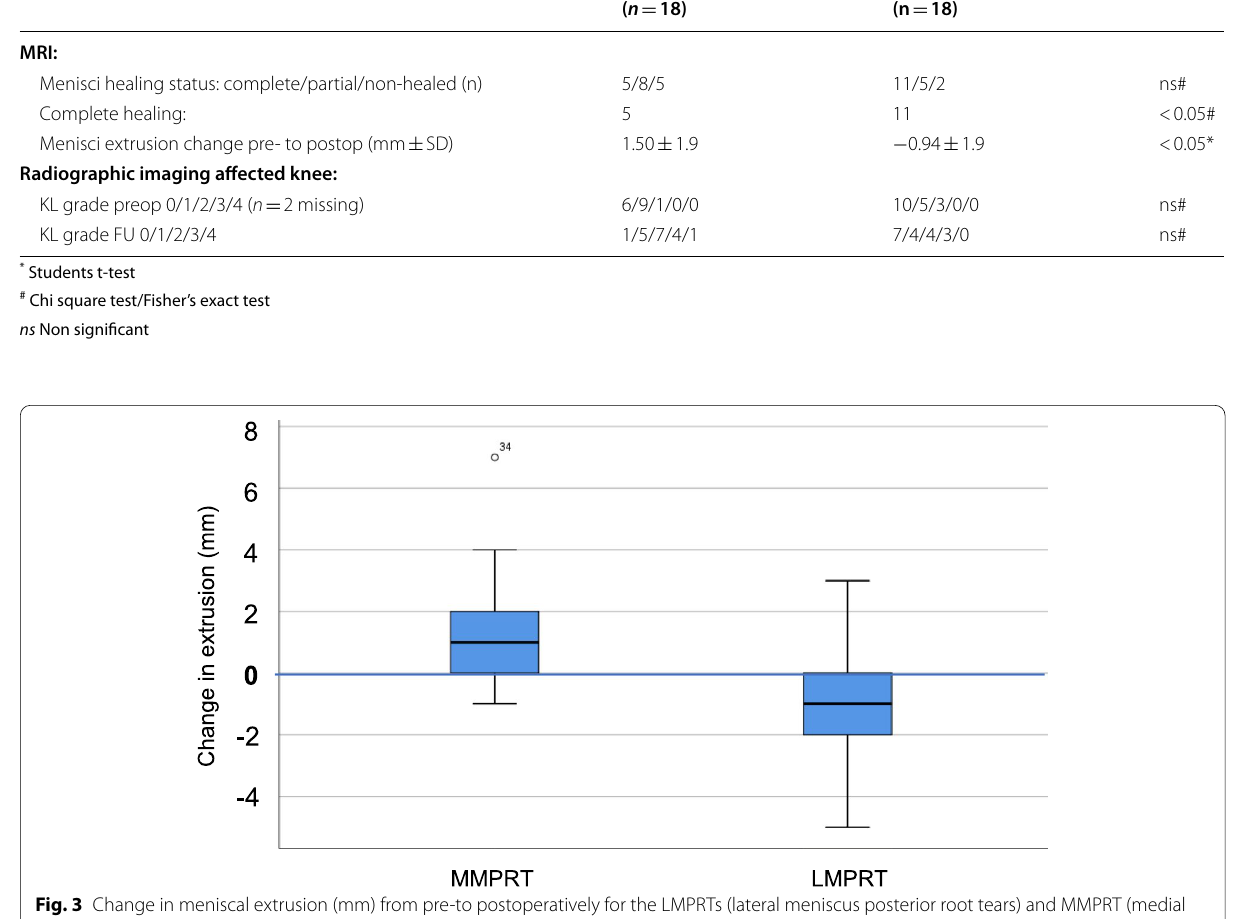
standard deviation) ±